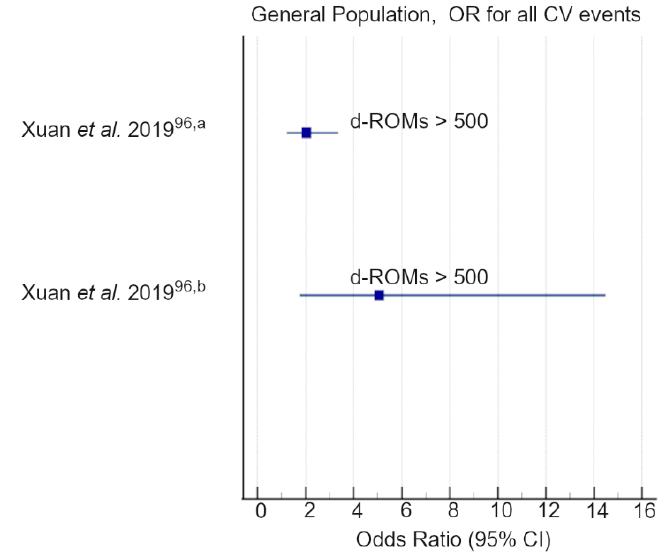
Figure 8. Graphical representation of the data reported in Table 3. The data were grouped depending on clinical outcomes (Xuan et al., 2018 [96] a OR for myocardial infarction; Xuan et al., 2018 [96] b OR for fatal myocardial Infarction) and statistical parameters (OR).